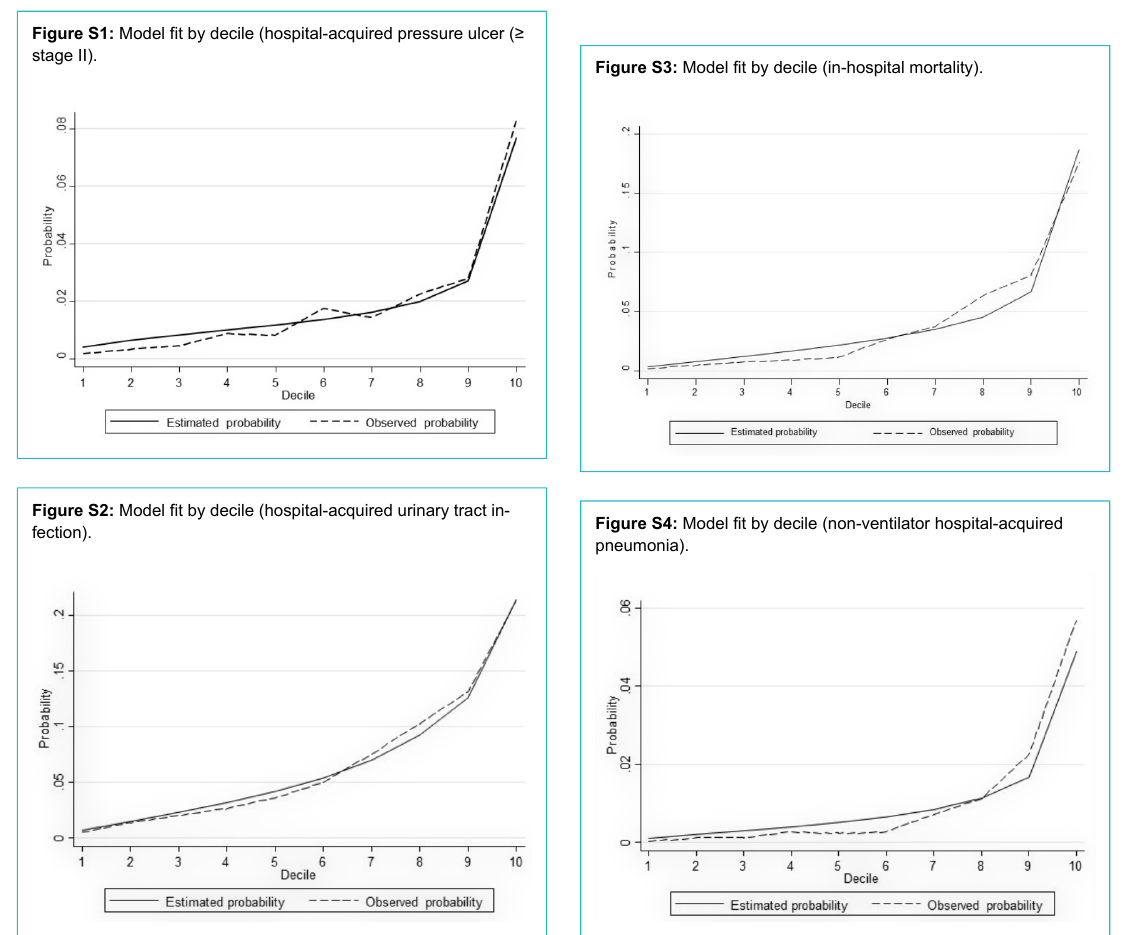
Figure S1: Model fit by decile (hospital-acquired pressure ulcer (≥ stage II).